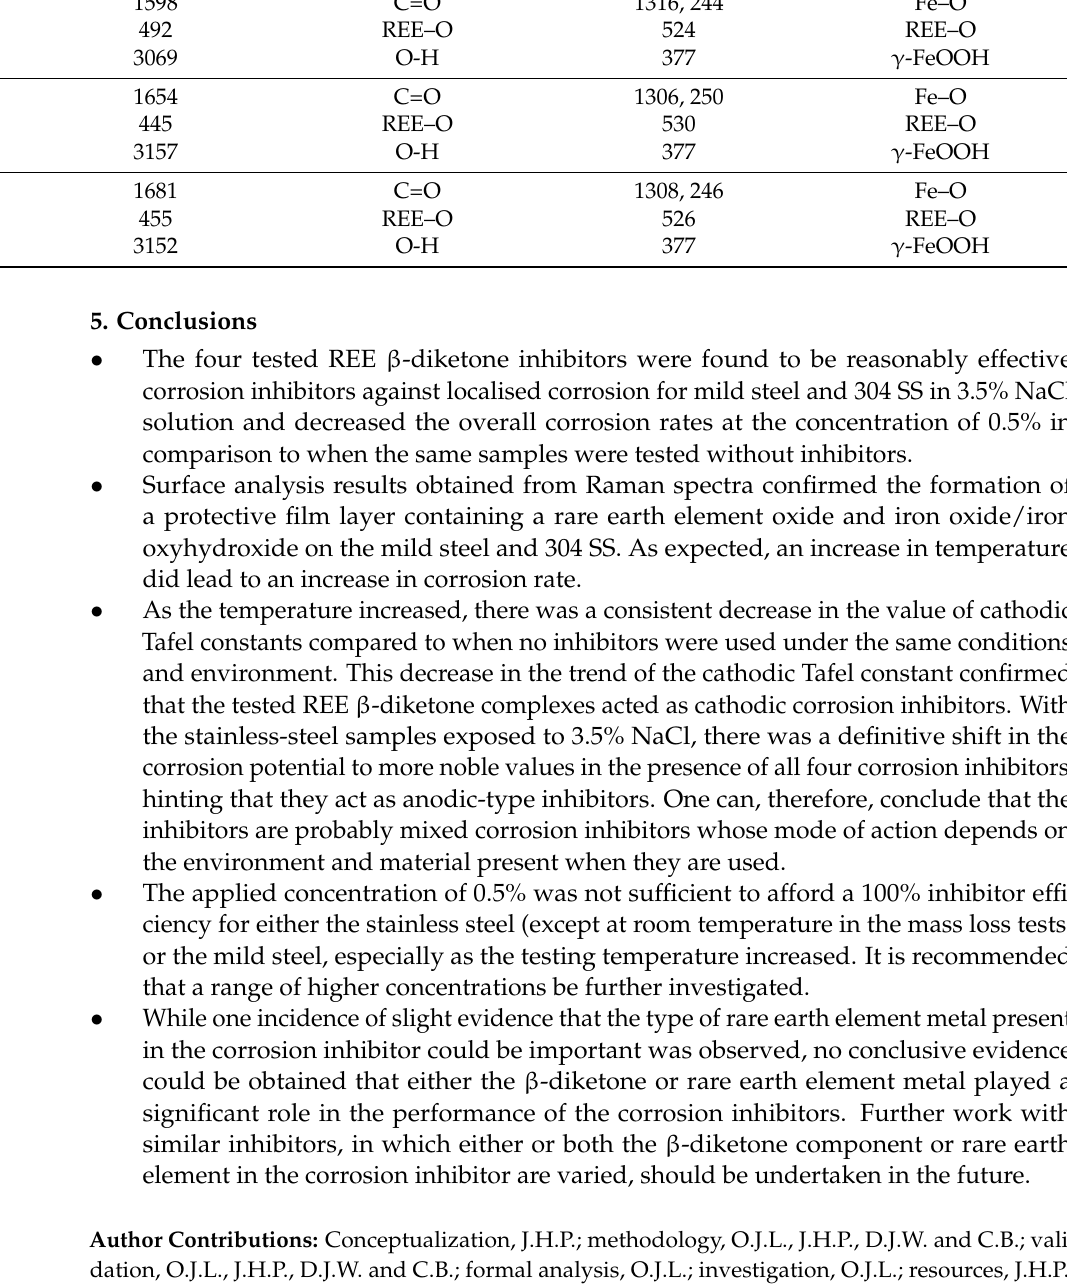
inhibitor and the corrosion products on mild steel and 3